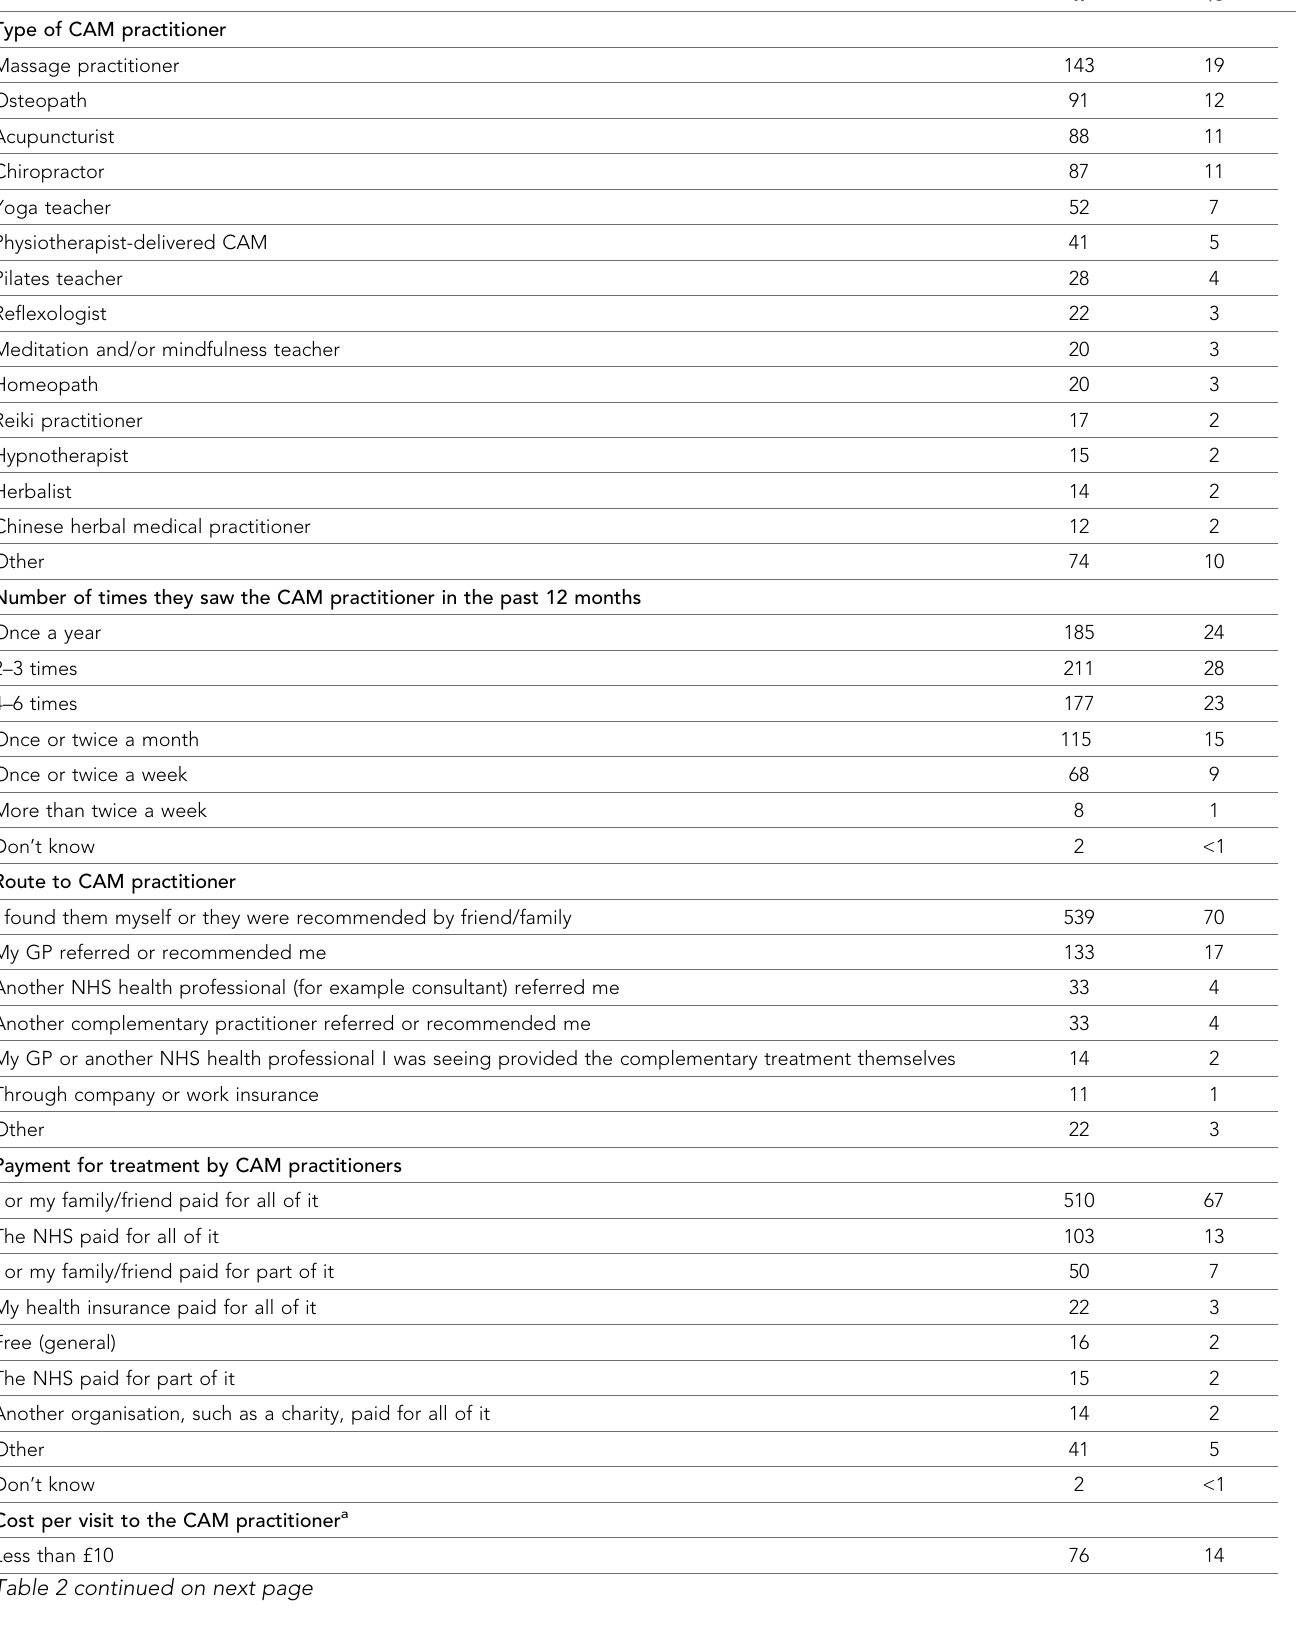
Table 2 Characteristics of CAM use ( n =